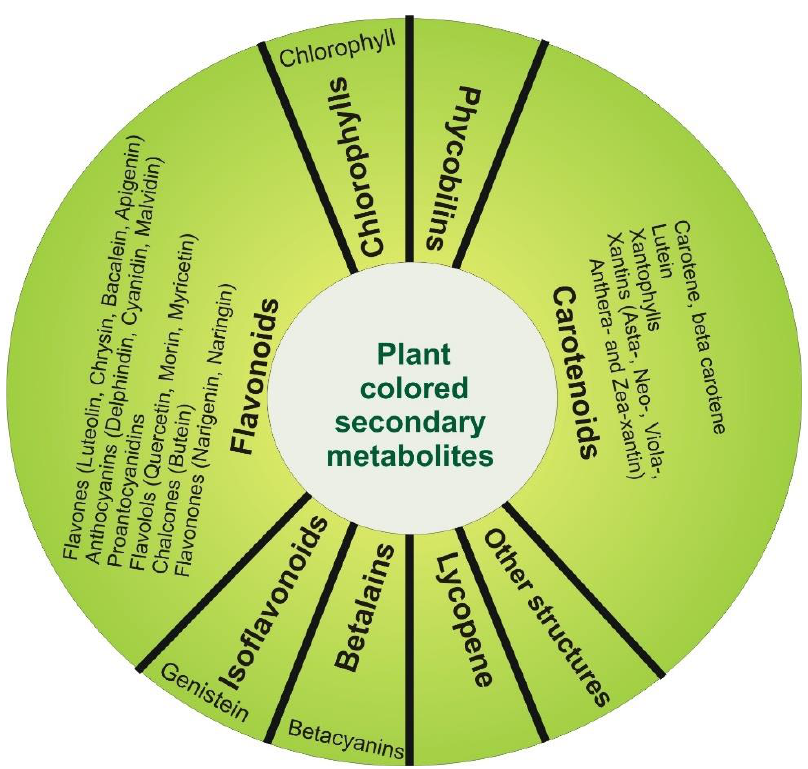
Figure 1. Colored secondary metabolites with anticancer effects.